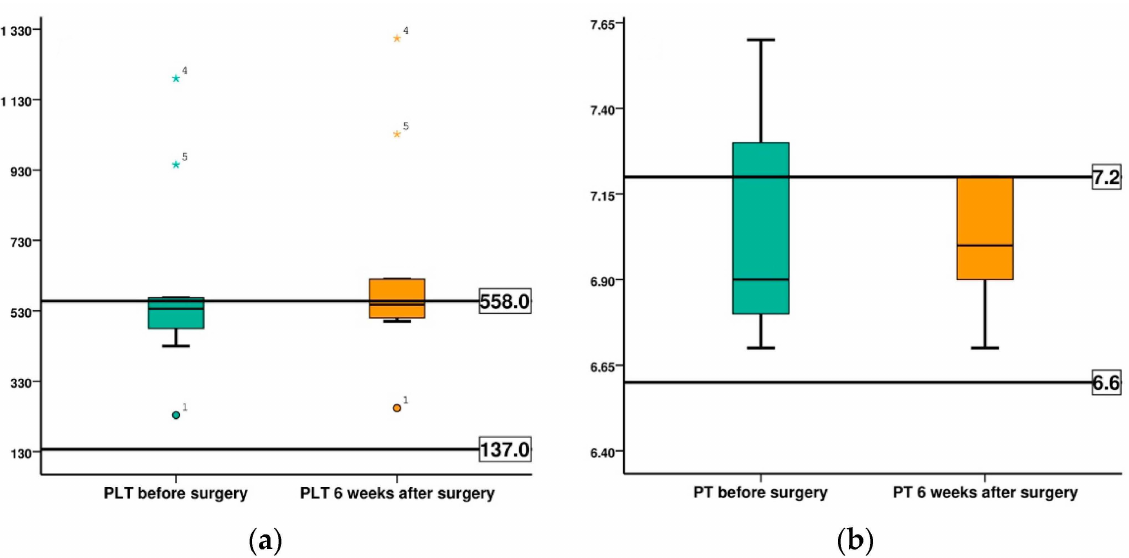
Figure 19. Comparison of the evolution of red platelets (PLT) and prothrombin time (PT), in both groups, before surgery (BS) and at 6 weeks after surgery (AS): ( a ) PLT; ( b ) PT.